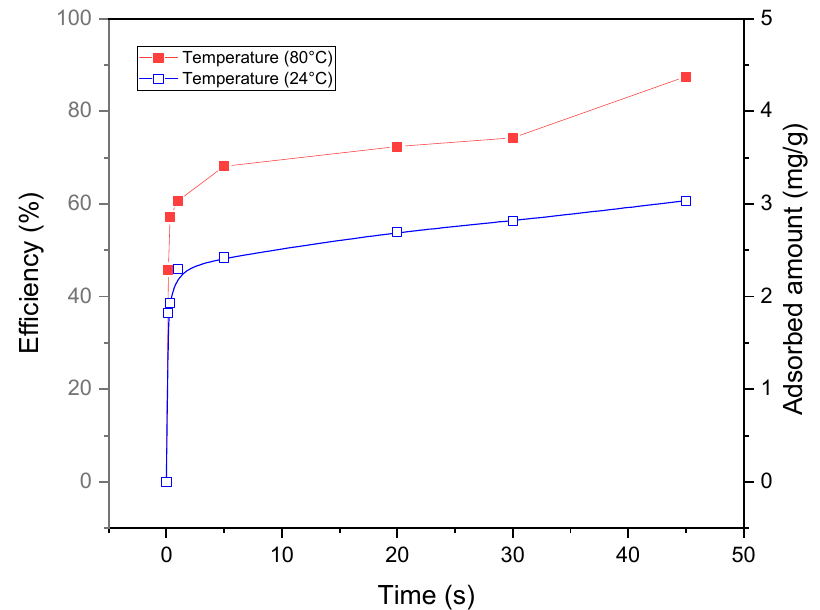
Figure 13. Effect of temperature on BR dye adsorption.